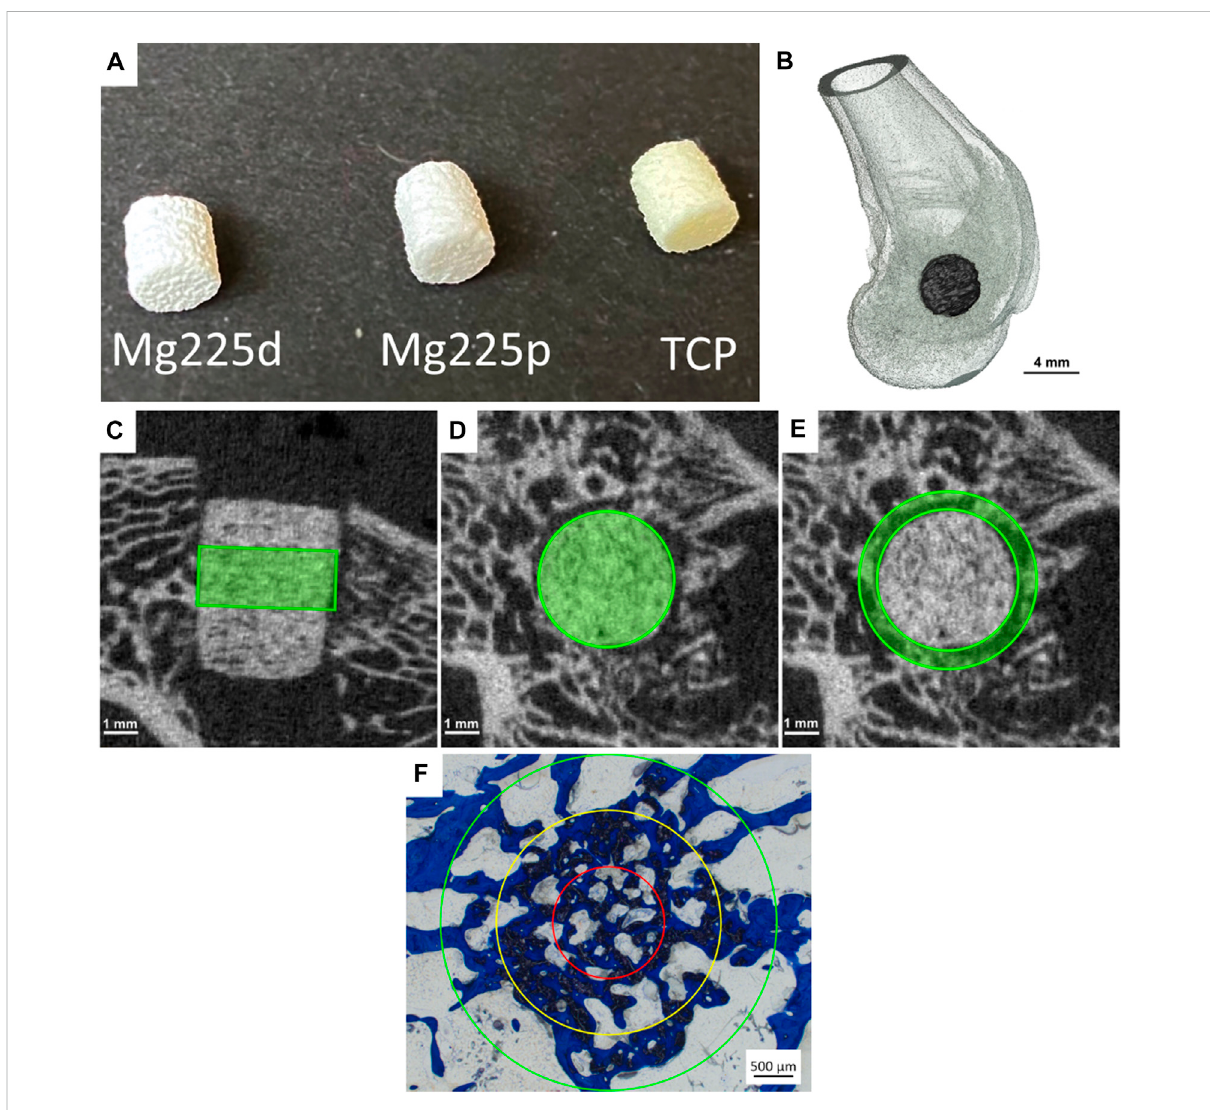
FIGURE 1 (A) Mg225d, Mg225p and TCPscaffoldsprior to implantation ( h =5.1 mm, Ø =4.2 mm). (B) Three-dimensional(3D)reconstructionof thedistal rabbit femur with implanted scaffold in the lateral condyle in lateral view. (C) Cylindrical region of interest (ROI) in the scaffold center for measurementofscaffoldvolume (SV)andscaffoldsurface/scaffoldvolume (SS/SV) intheoriginal in-vivo µCT scan( h = 60slices a 1.82 mm) and (D) in the reoriented in-vivo µCT scan ( Ø = 140 voxels ( a 4.24 mm)). (E) Second hollow cylindrical ROI for measurement of bone volume (BV), trabecular number (Tb.N), trabecular thickness (Tb.Th) and trabecular separation (Tb.Sp) in the scaffold environment in the reoriented in-vivo µCT scan (inner ring: Ø = 144 voxels ( a 4.36 mm), outer ring: Ø = 180 voxels ( a 5.45 mm), h = 60 slices a 1.82 mm). (F) ROIs for the semi-quantitative